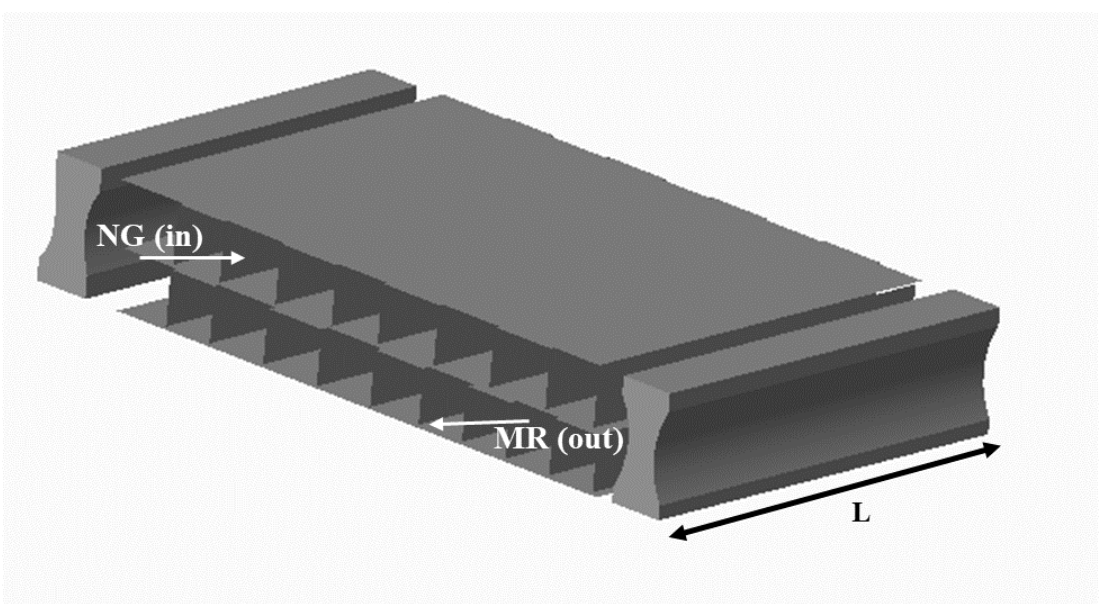
Figure 6. Plate-fin heat exchanger flow assembly.